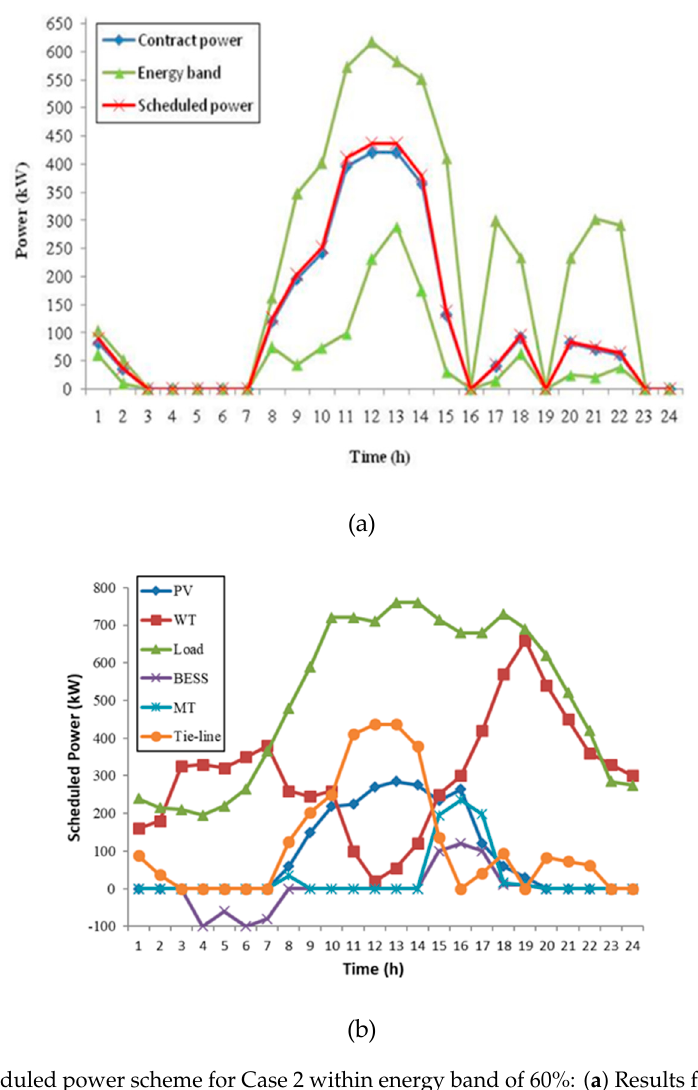
Figure 11. Scheduled power scheme for Case 2 within energy band of 60%: ( a ) Results for energy band, ( b ) Scheduled power volumes for distributed units. Table 7. Comparison of operational costs for each case.